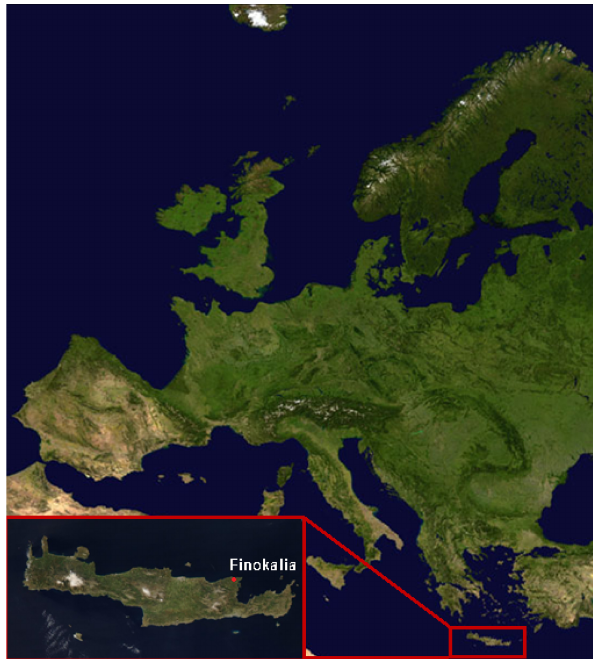
Fig. 1. NASA satellite images of Europe and of the island of Crete, indicating the location of the sampling station at